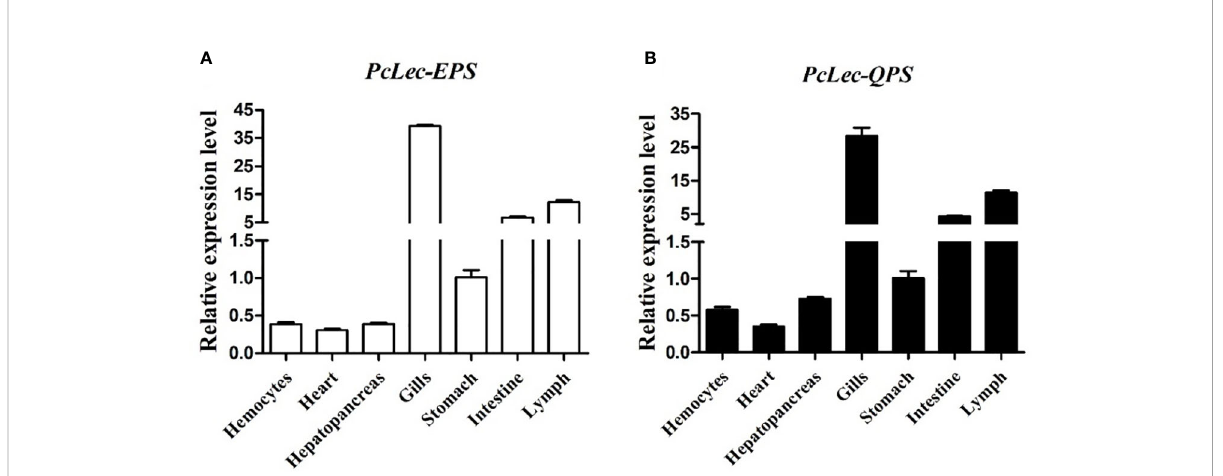
FIGURE 2 Relative expression levels of (A) PcLec-EPS and (B) PcLec-QPS in seven tissues (hemocytes, heart, hepatopancreas, gills, stomach, intestine, and lymph) were detected by RT- qPCR. 18S rRNA was used as an internal reference gene for internal normalization. The values were shown as mean ± SD, N =